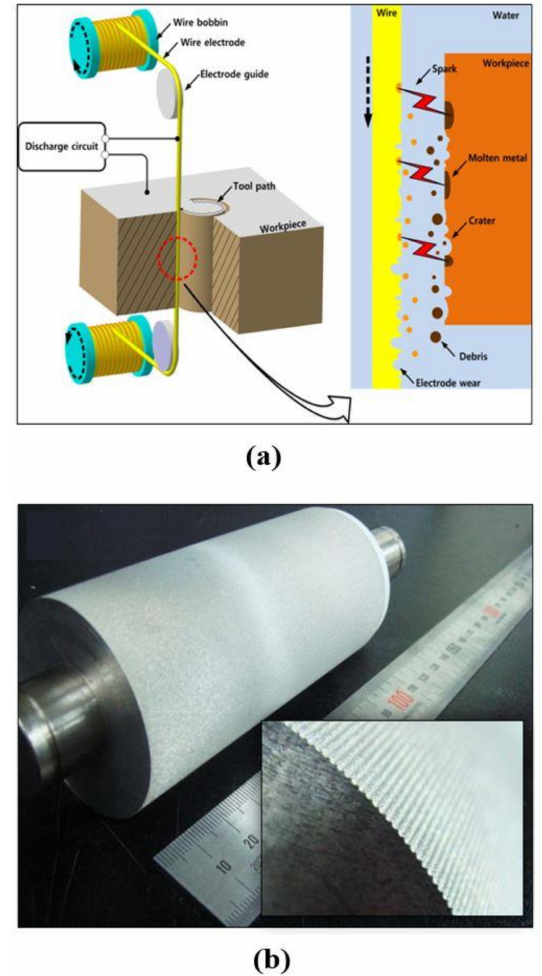
Figure 6. ( a ) Schematic diagram of WEDM process used to fabricate multi-scale patterned roll; ( b ) Optical images of the fabricated multi-scale patterned roll for roll-to roll